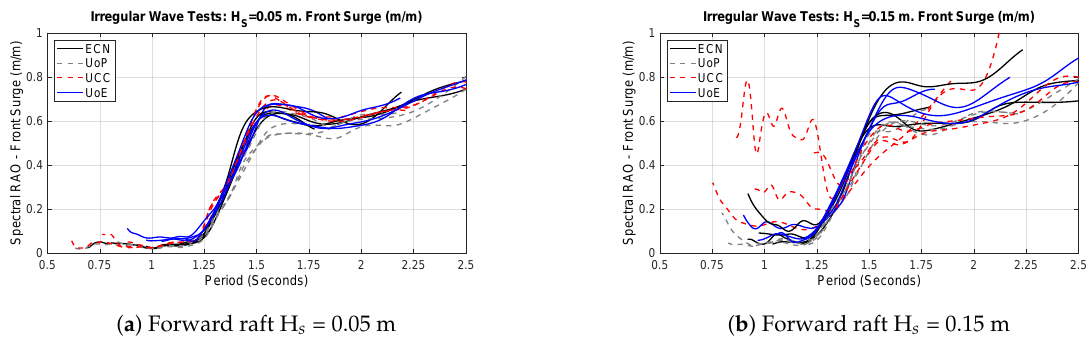
Figure 13. Additional forward raft surge RAOs for H s = 0.05 m and 0.15